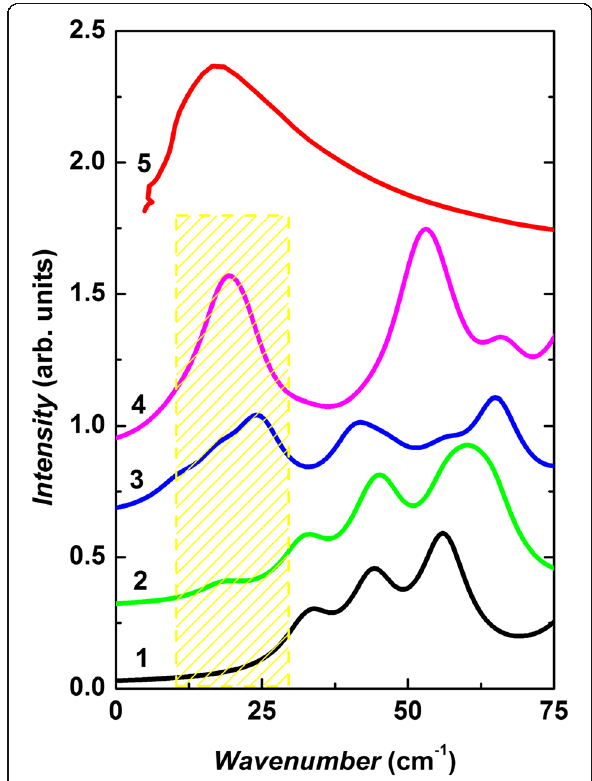
Fig. 6 Simulated low-frequency Raman spectra of As n S m ring-like clusters ( 1 – 4 ): ( 1 ) As 6 S 6+6/2 , ( 2 ) As 5 S 5+5/2 , ( 3 ) As 4 S 4+4/2 , ( 4 ) As 3 S 3+3/2 and g ( ω )/ ω 2 (10 K, ref. [11]) of g-As 2 S 3 ( 5 ). ( Color online